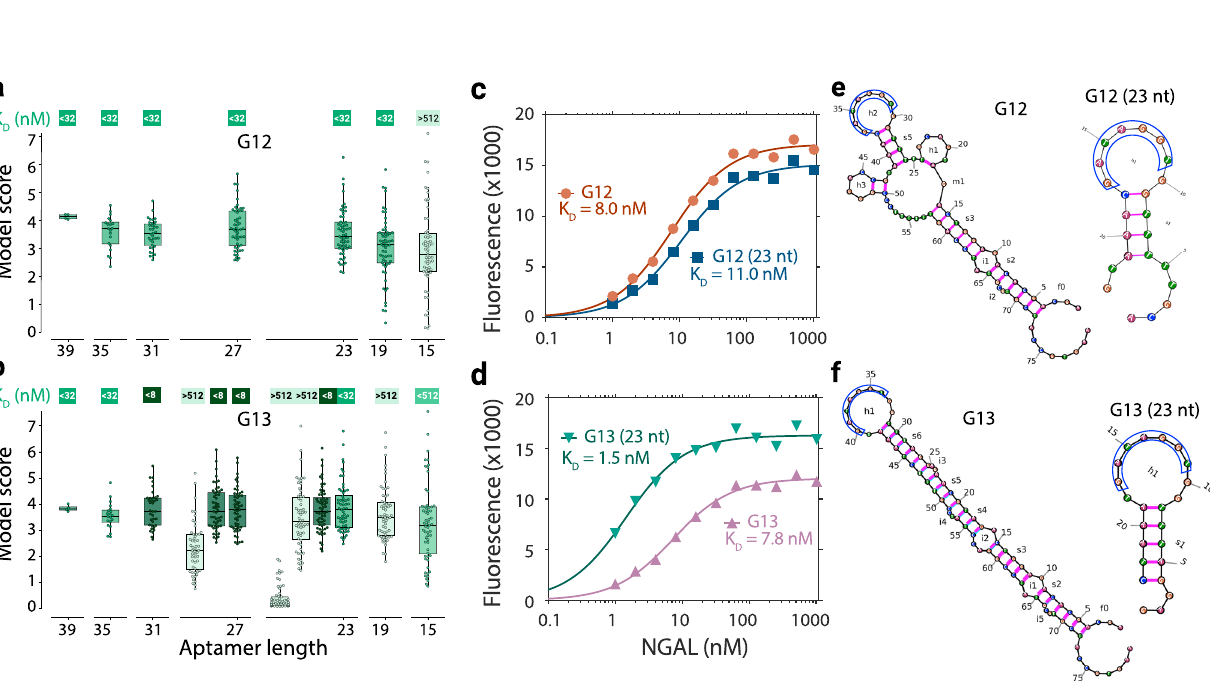
Fig. 4 Performance of machine learning directed aptamer length truncation. a , b Box-plots and swarmplots showing model scores for candidate aptamers calculated across multiple sequence backgrounds. Each swarm/box plot corresponds to one core sequence: each point represents the core sequence in a different sequence background, each box represents the median, lower, and upper quartiles, and whiskers correspond to 1.5x the interquartile range. Sequence lengths with multiple swarm/box plots indicate cases where multiple different subsequences of the same length were tested experimentally. Particle display af fi nity level for a truncated sequence is shown by shade of green in the corresponding swarm. c , d K D curves showing the af fi nity of the full-length sequences (orange, purple) and 23 nt truncations (blue, teal) for G12 and G13, respectively. e , f Secondary structures of the full-length sequence and 23 nucleotide (nt) truncations for G12 and G13, respectively. Each nt is indicated by a small circle (A (maroon), C (blue), G (brown), T (green)). Covalent bonds in the phosphodiester backbone are shown in black and hydrogen bonds between bases are shown in magenta). The TGGATAG motif is outlined in